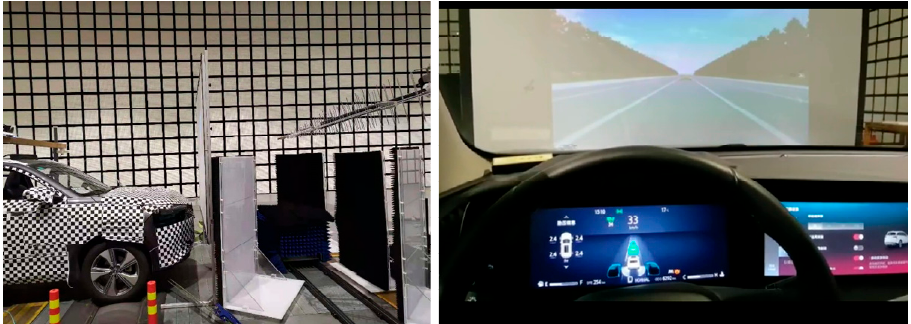
Figure 12. Arrangement of radiated immunity for ADAS functions in an anechoic chamber ( left ) and the ACC function activation in the vehicle ( right ).